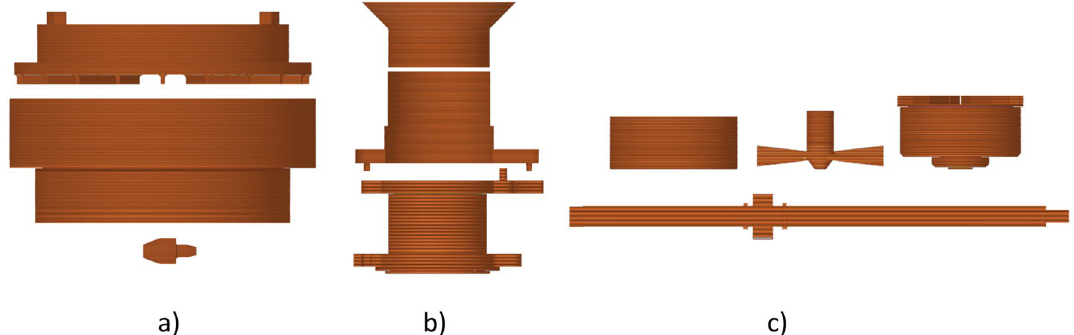
Figure 2. ( a ) The layering of the Schulze’s small ring cell (S size), lid, and driving pins; ( b ) the layering of the FT4’s bottom part, upper part, and funnel; ( c ) the layering of the FT4’s shaft with the nut, shear head, blade, and vented piston. Layering was generated by PrusaSlicer version 2.3.0. This figure was created in Gimp 2.10.32.